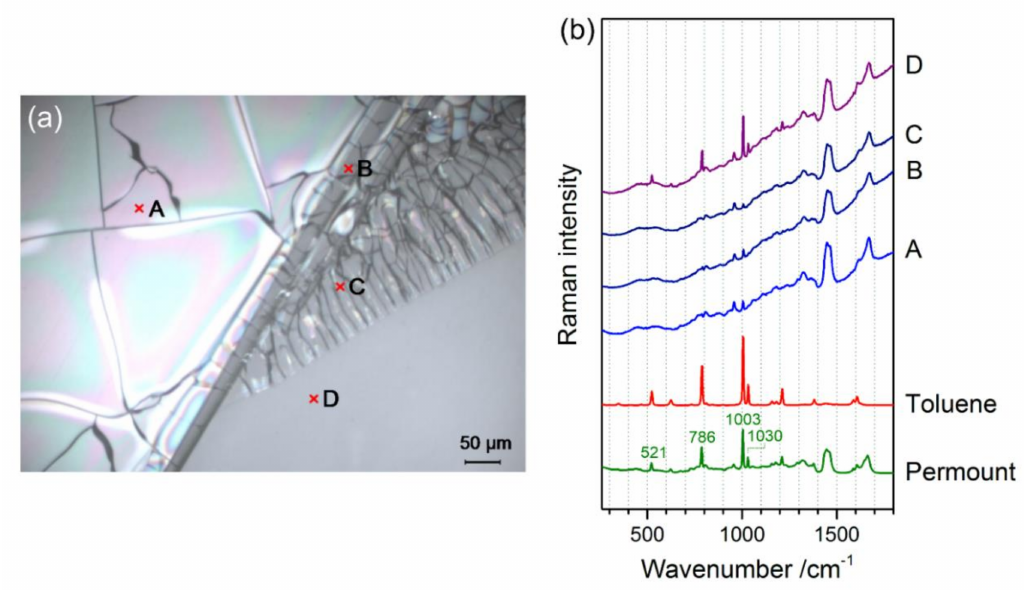
Figure 3. Determination of the reason for crack formation in Permount TM by Raman microscopy: ( a ) reflected light micrograph, and ( b ) Raman spectra of the Permount TM mounting medium, the solvent toluene, and of the measurement spots ( A – D ) in sample USNM 1226533, Cateria gerlachi , marked in ( a ).